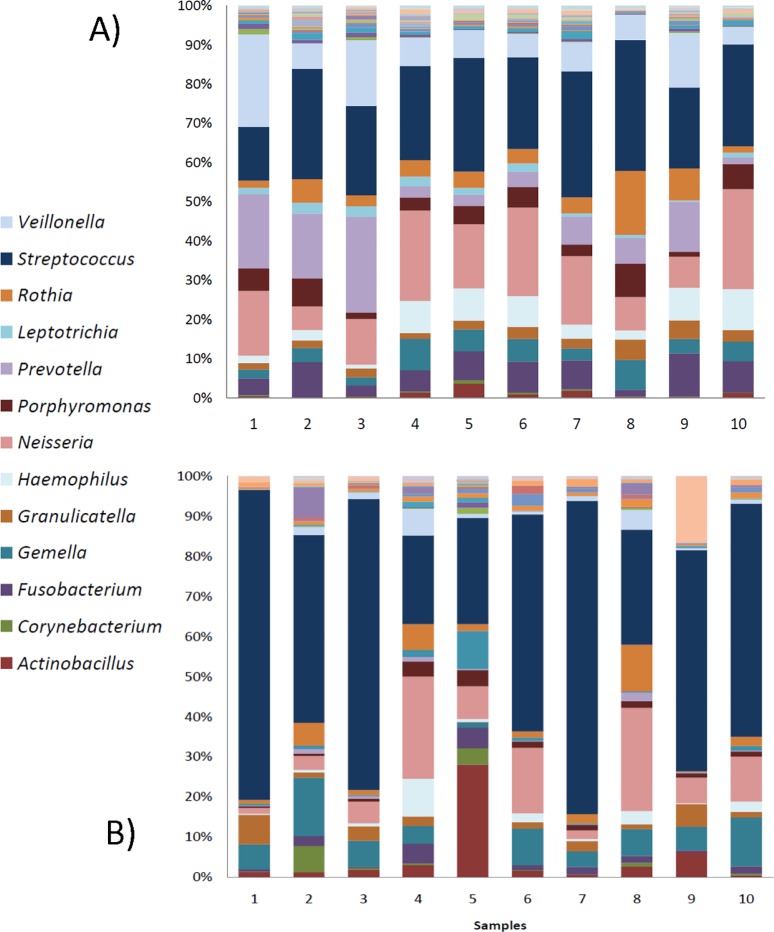
Salivary bacterial composition at the genus level in stimulated (A) and unstimulated (B) saliva samples. Markedly different proportions of bacterial genera are observed between the two sample types, including an increased presence of Streptococcus in unstimulated saliva, and higher proportions of anaerobic microorganisms in stimulated saliva. Legend indicates those genera present at a proportion >1%.